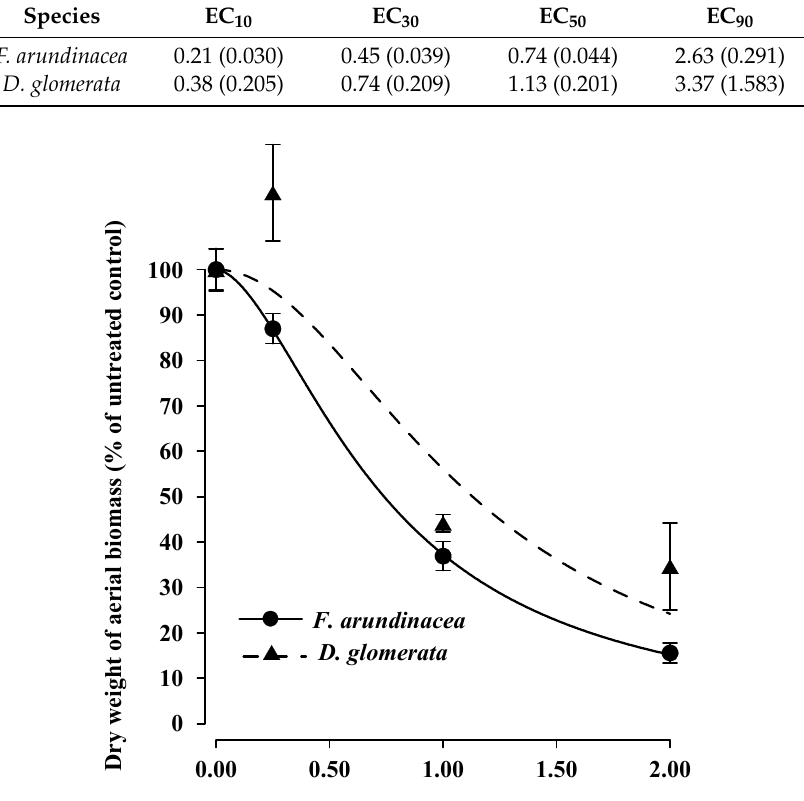
Table 1. EC 10 , EC 30 , EC 50 , and EC 90 (effective concentration) values (mg L − 1 ) estimated from dose response curves of aerial biomass of regrowth of F. arundinacea (tall fescue) and D. glomerata (orchardgrass) treated with different S-metolachlor (SMR) concentrations (Figure 2). Regrowth was measured at 87 days after treatment (DAT) after the mowing at 36 DAT. Standard errors are in parenthesis. Species EC 10